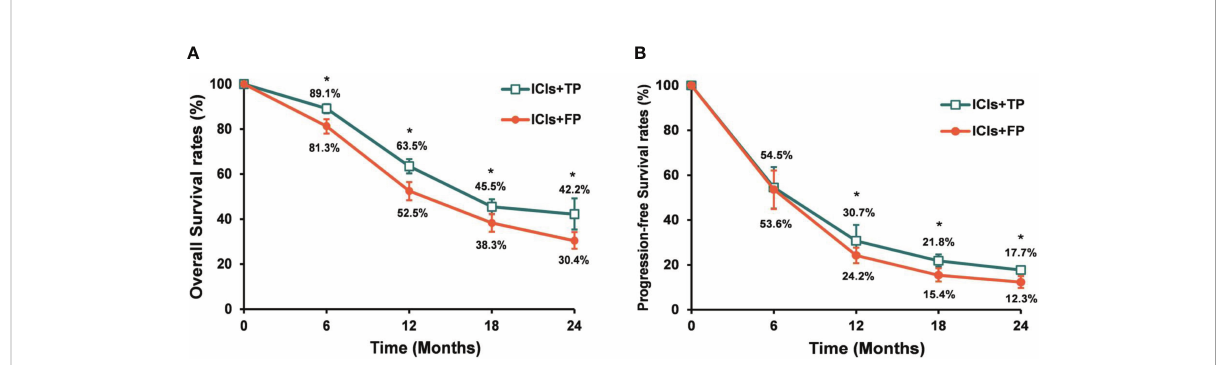
FIGURE 3 Pooled OS rates (A) and PFS rates (B) for the ICIs+TP and ICIs+FP groups among ESCC patients who received chemo-immunotherapy. OS, overall survival; PFS, progression free survival; ICIs, immune checkpoint inhibitors; TP, paclitaxel plus cisplatin (TP); FP, 5- fl uorouracil plus